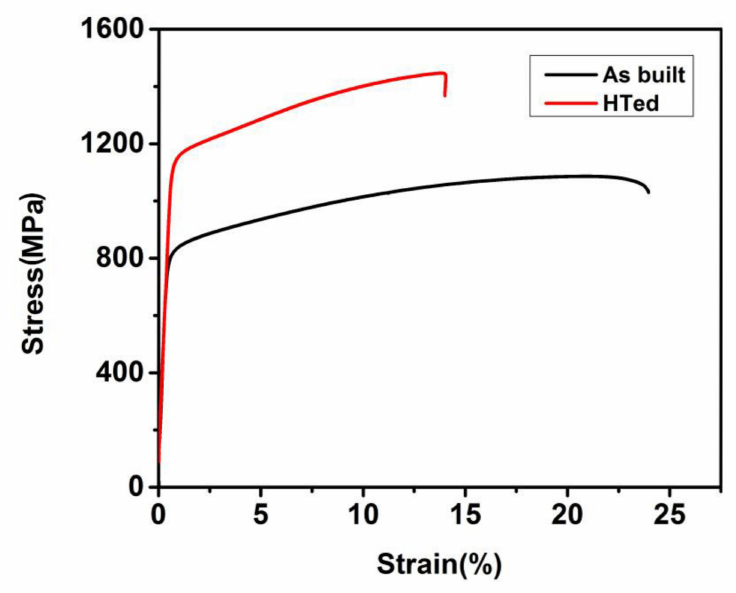
Figure 7. Typical tensile strain-stress curves of the GTD222 at different states. The UTS and YS of the HTed GTD222 at room temperature are 1424 ± 7 MPa and 1120 ± 6 MPa, respectively. The UTS and YS of the as-built GTD222 at ambient temperature were 1100 ± 7 MPa and 831 ± 5 MPa, respectively. However, the elongation of the HTed GTD222 was inferior to as-built GTD222, which is decreased from 24.3 ± 2.5% to 13.7 ± 1.4%. The fracture morphologies of the as-built and HTed GTD222 samples were displayed in Figure 8.